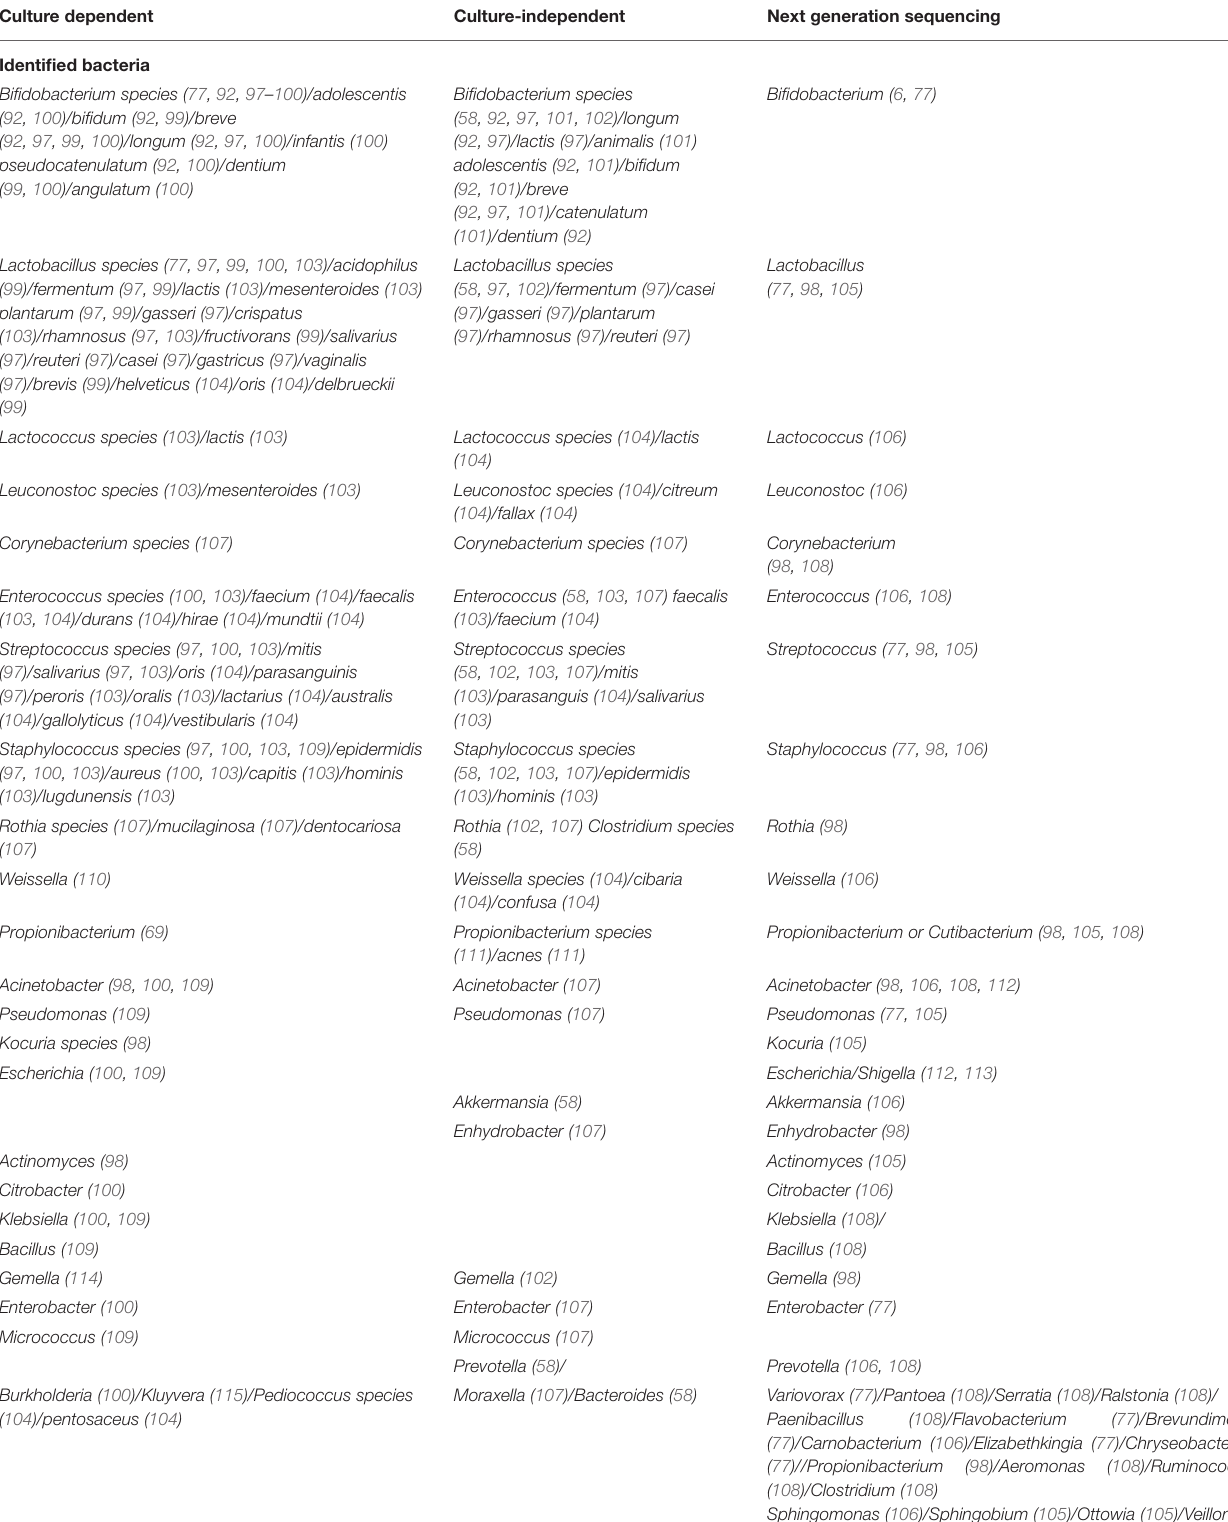
TABLE 2 | Bacterial populations detected in raw human milk using culture-dependent, culture-independent, and next-generation DNA sequencing methods. Culture